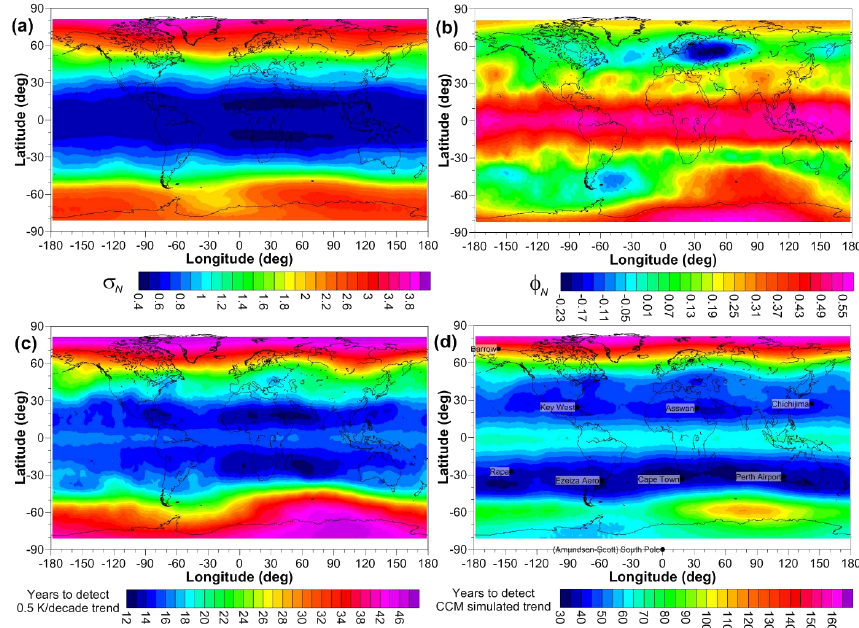
Figure 9. Analyses of merged MSU channel 4 and AMSU channel 9 temperature data – 1978 to 2013. (a) Standard deviation of regres- sion model residuals, (b) the first-order autocorrelation coefficient of the residuals, (c) the number of years required to detect a trend of 0.5Kdecade − 1 , and (d) the number of years required to detect the trend at 17.5km altitude (close to where the MSU channel 4 and AMSU channel 9 weighting functions peak) as shown in Fig. 6. Only existing GUAN and GRUAN stations have been used as a basis to select the optimal sites for early trend detection shown